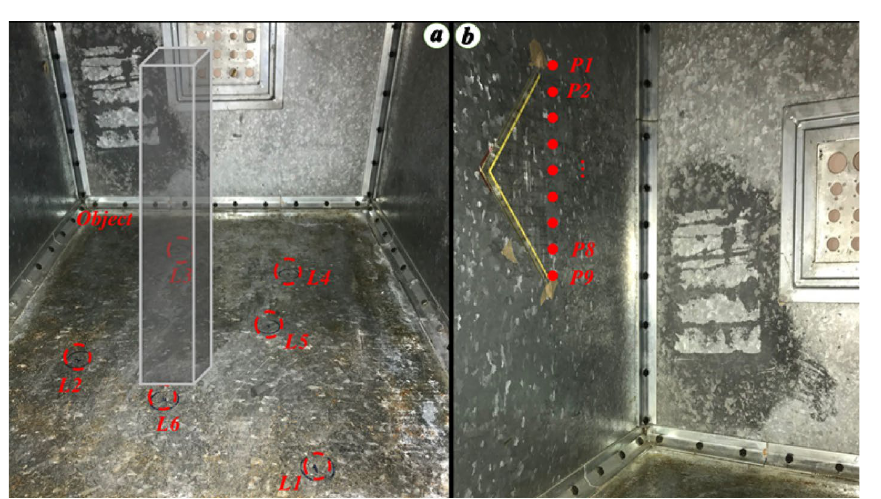
Figure 8. Assumed PD locations. ( a ) On the floor of the tank ( L 1 , …, L 6 ). For better illustration, the metallic object was removed temporarily and replaced with a translucid parallelepiped, ( b ) On the left-wall of the transformer tank, P 1 , …, P 9 are spaced 2.5 cm from each